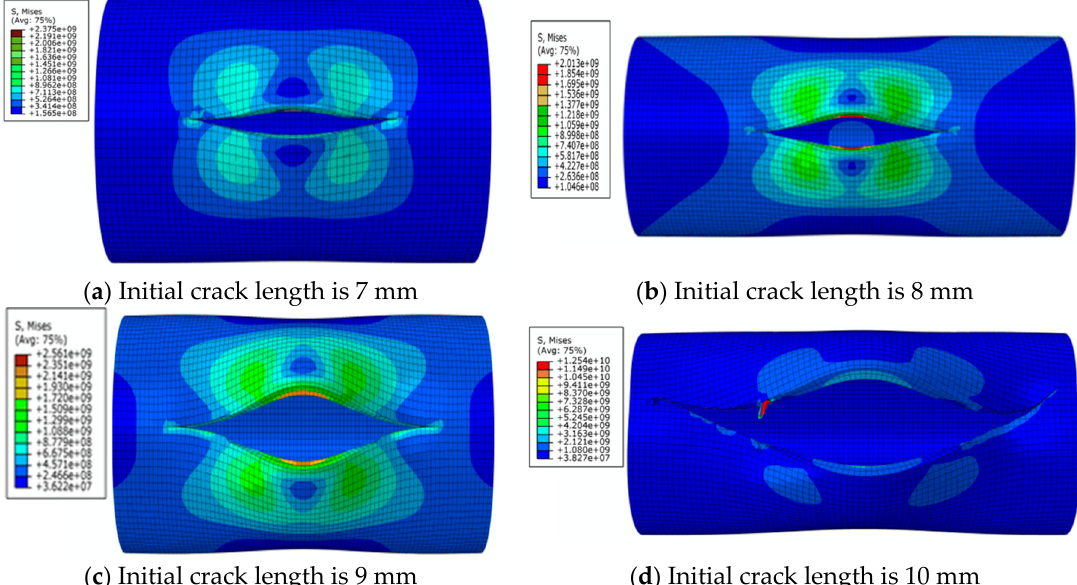
Figure 9. The von Mises stress distribution for different initial crack lengths, where the internal pressure is 28 MPa (here, images are magnified 10 times for visual display)